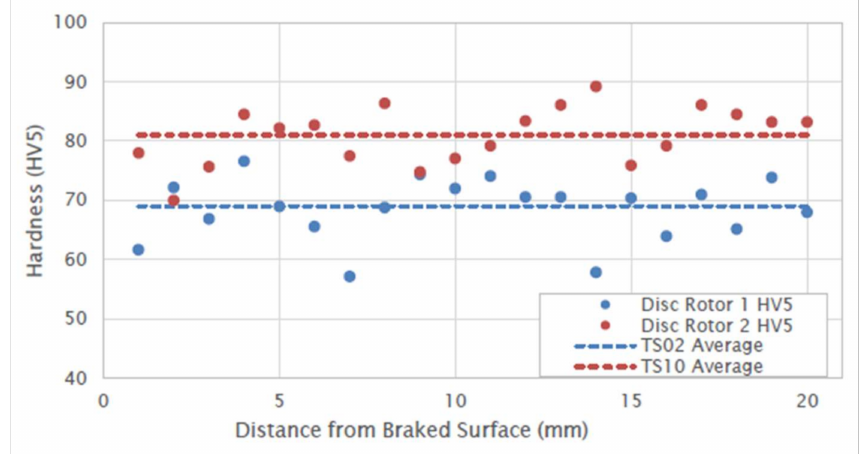
Figure 6. Through-thickness hardness traverse